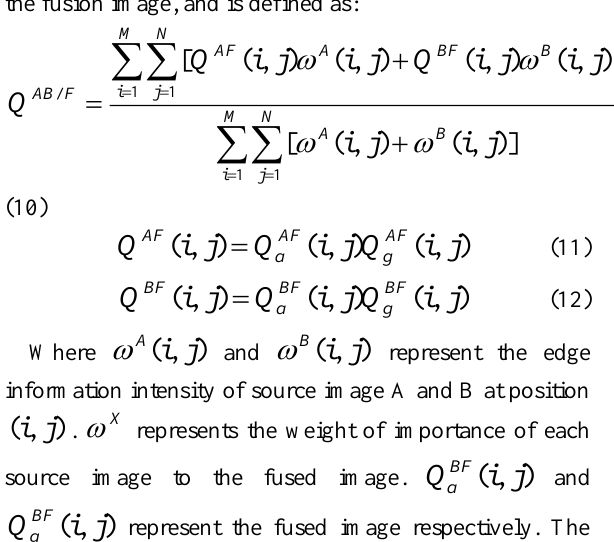
Figure 6. Results of infrared and visible image fusion based on TNO and VIFB dataset with different algorithms